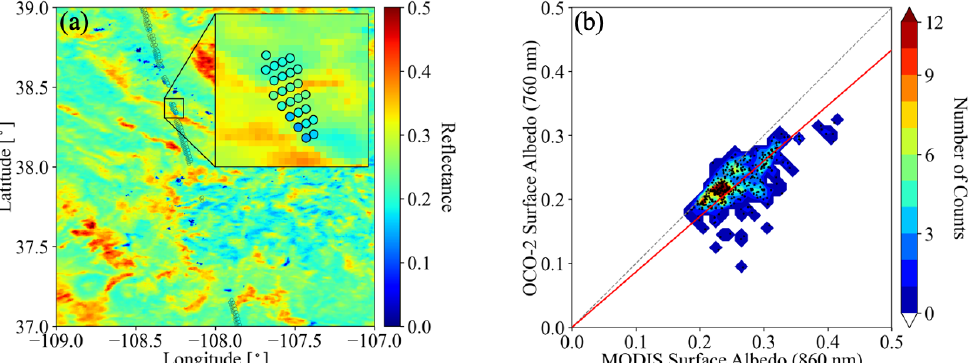
Figure 4. (a) Surface albedo from the OCO-2 L2 product in the oxygen A-band (near 760nm), overlaid on the surface albedo from the MODIS MCD43A3 product at 860nm. (b) OCO-2 surface albedo at 760nm versus MODIS surface albedo at 860nm, along with linear regression ( α OCO = c · α MOD ) as indicated by the red line (slope c = 0.867).